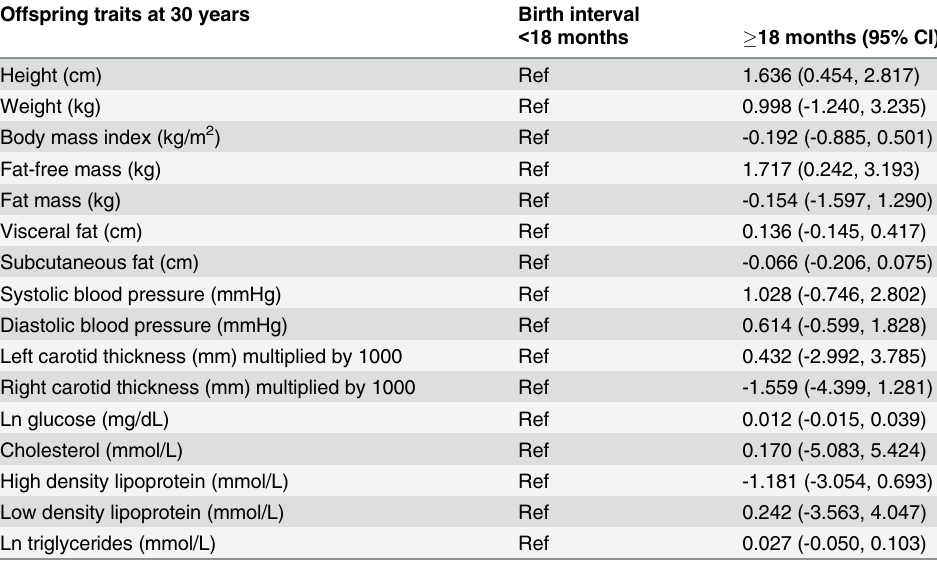
Table 4. Multivariable regression results with birth interval as a binary